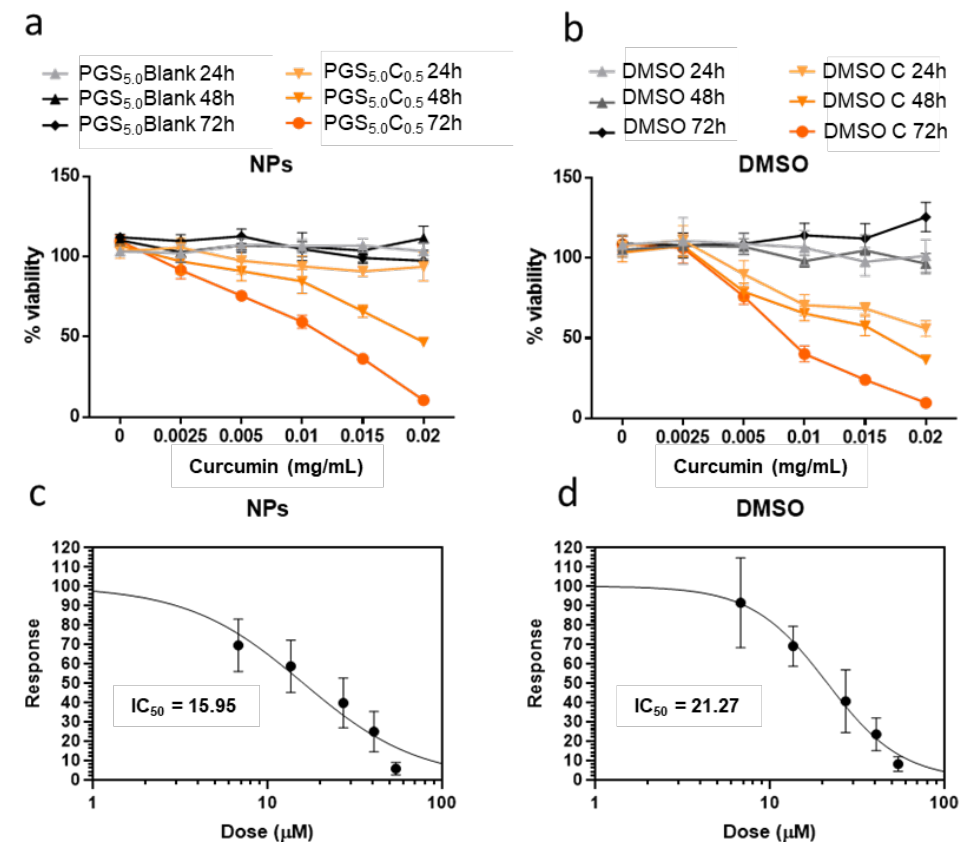
Figure 7. Cytotoxicity assay in HeLa cervical cancer cells with different concentrations of PGS 5.0 Blank and PGS 5.0 C 0.5 dissolved in sterile dH 2 O ( a ) and of free curcumin dissolved in DMSO (DMSO-C, b ). Values are means ± SEM (n = 12). IC 50 values calculated are based on cell viability of HeLa cells at 72 h after treatment with PGS 5.0 C 0.5 ( c ) and free curcumin dissolved in DMSO ( d ). 2.7. Effect of Curcumin-Loaded PGS-NPs in Inducing Apoptosis of HeLa Cells